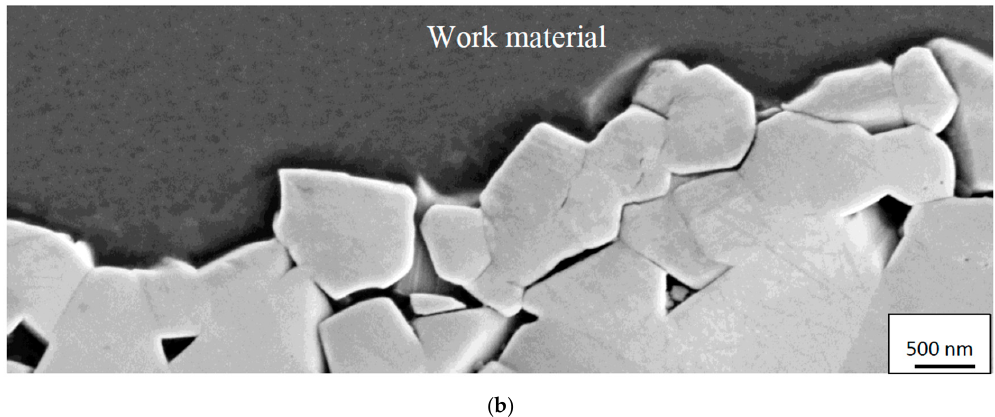
Figure 12. Cross-section of the crater showing the worn rough cemented carbide surface illustrating the presence of an attrition wear mechanism at lower magnification ( a ) and higher magnification ( b ). Attrition wear was found to dominate for combinations of lower cutting feeds/cutting speeds. Chip sliding direction from right to left.